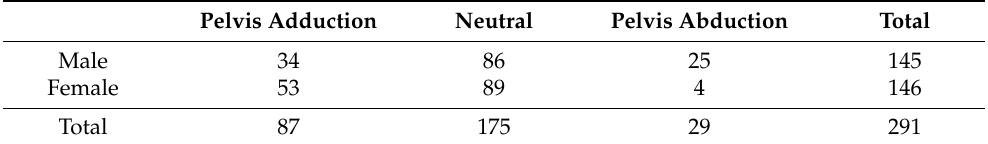
Table 9. Cross tabulation analysis of pelvis adduction/abduction by gender (X 2 = 19.41, DF = 2, p -value =